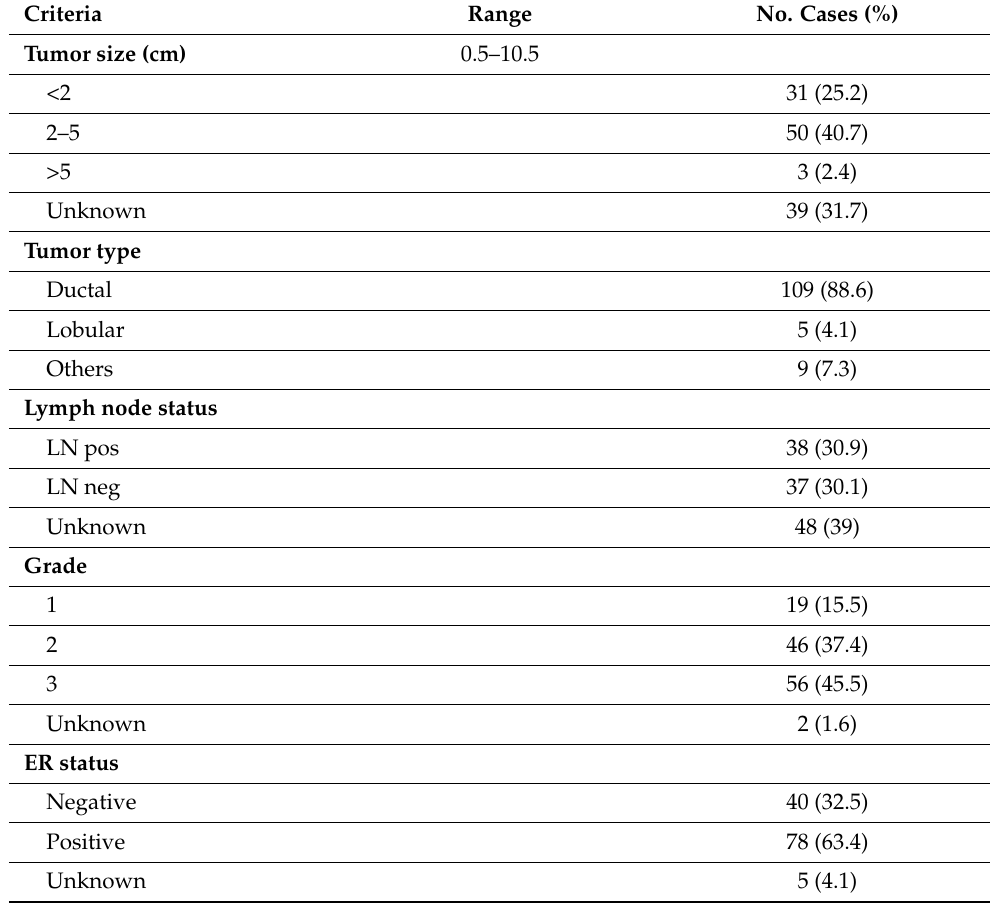
Table 1. Clinical and pathological characteristics of the study population ( n = 123 subjects).